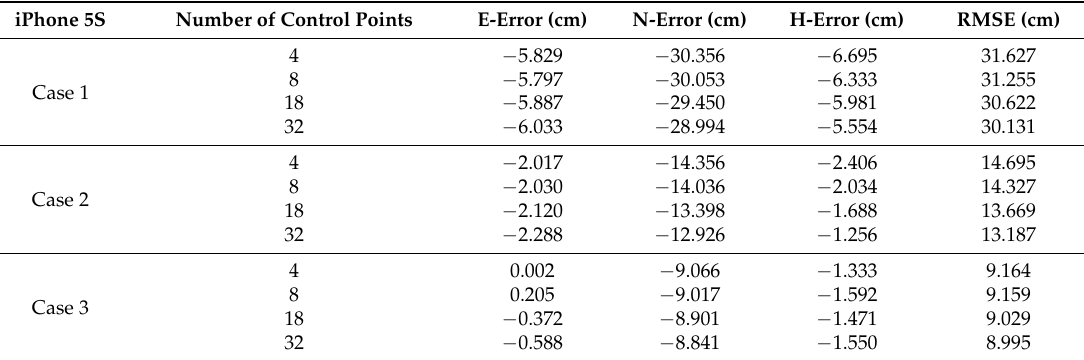
Table 5. The position error of quantity analysis for HTC M8.